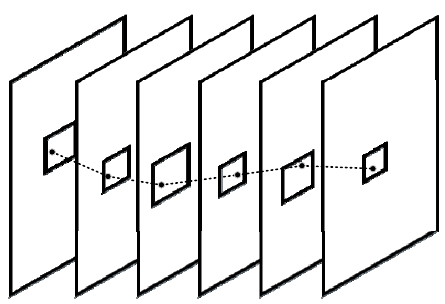
Figure 8. Schematic diagram of the adaptive weighted moving pipeline filtering (AWMPF).